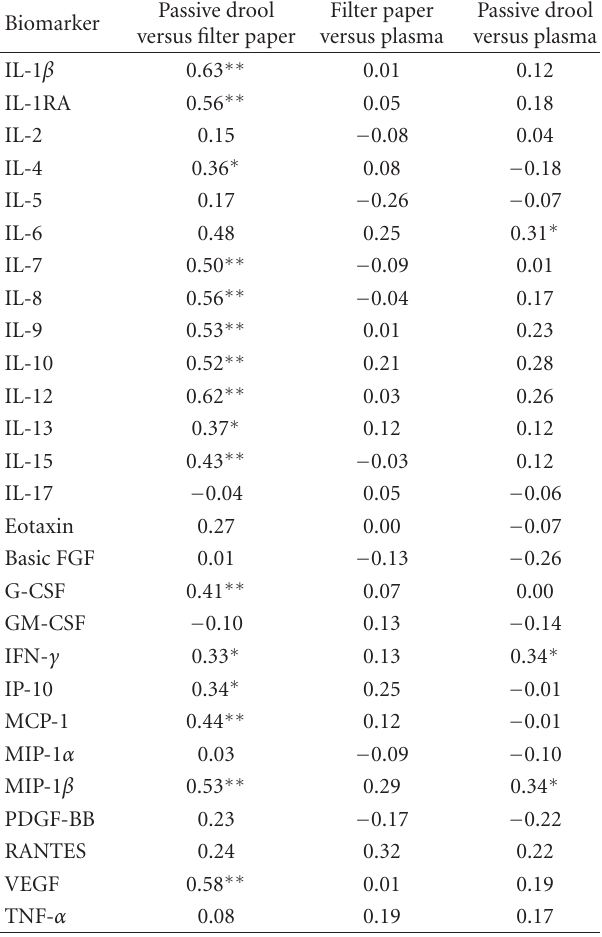
Table 1: Correlations of biomarkers among passive drool saliva, filter paper saliva, and plasma